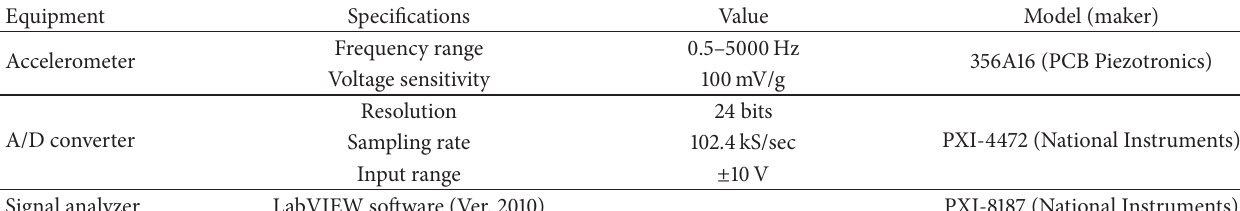
Table 2: Specifications of condition monitoring